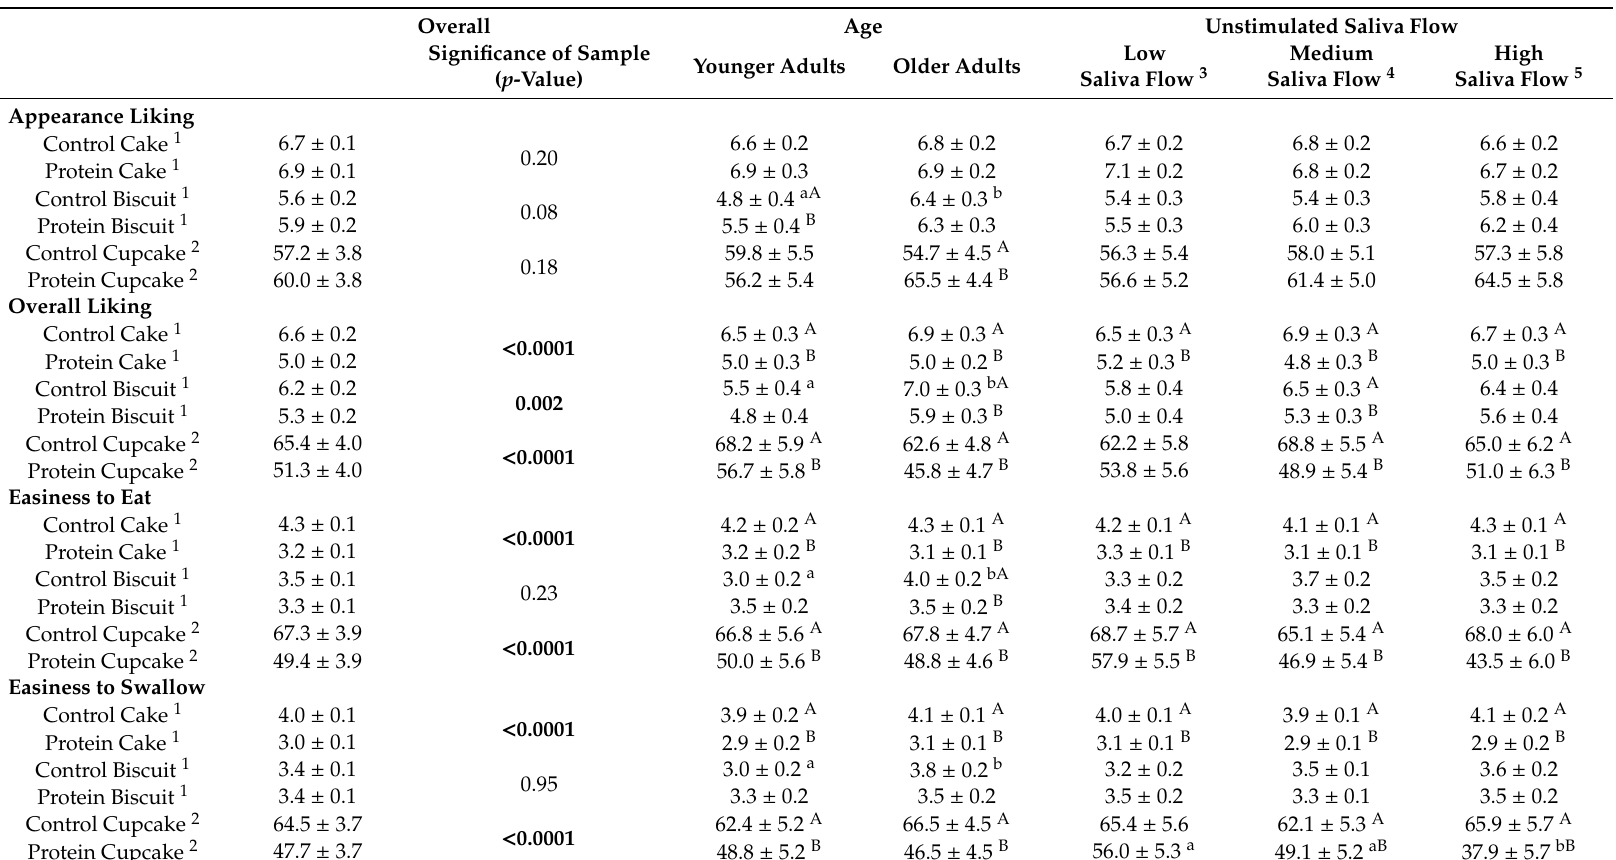
Table 6. Volunteers’ liking and easiness to eat and swallow mean ratings of cakes, biscuits and cupcakes in both studies; overall and by age and unstimulated saliva flow